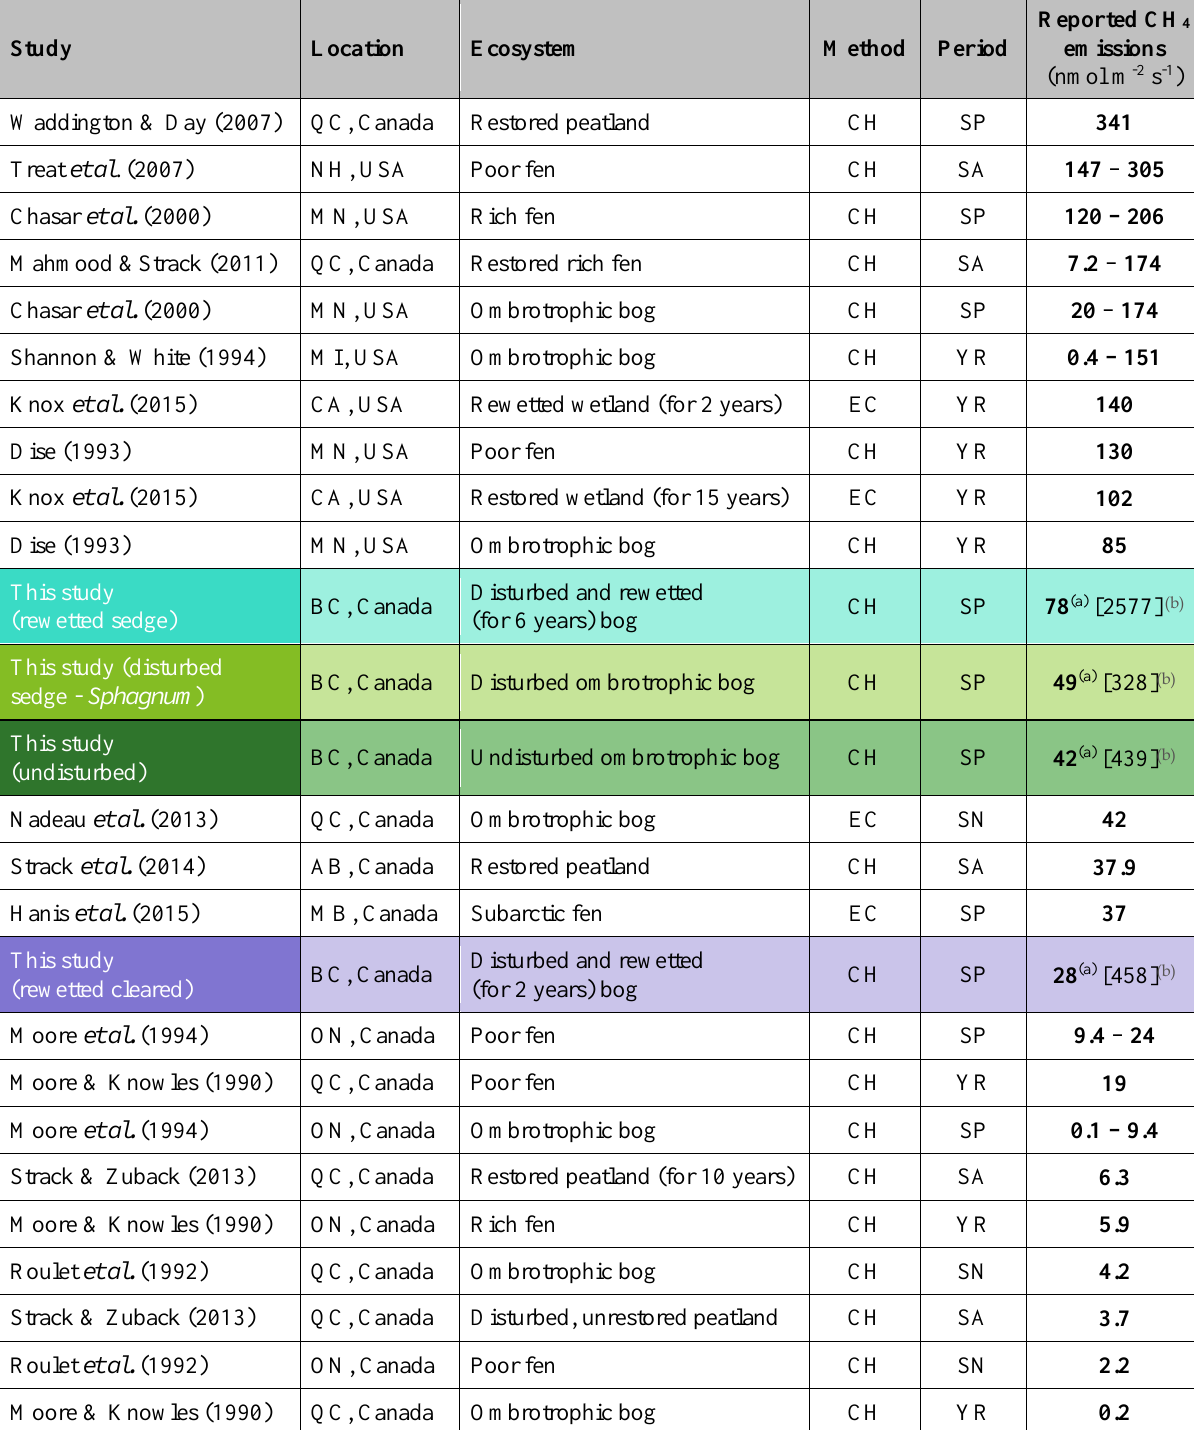
Table 4. Comparison of average methane (CH 4 ) fluxes (and median values in square brackets) measured in this study with averages reported in the literature on fluxes from wetlands in temperate / boreal North America. Studies are sorted from high to low CH 4 emissions. The fourth column refers to the measurement method, where “CH” means chamber technique, “EC” means eddy covariance technique; the fifth column refers to the period of measurements, where “YR” are year-round, “SA” are seasonal (summer season or growing season) averages, and “SP” are sporadic measurements limited in